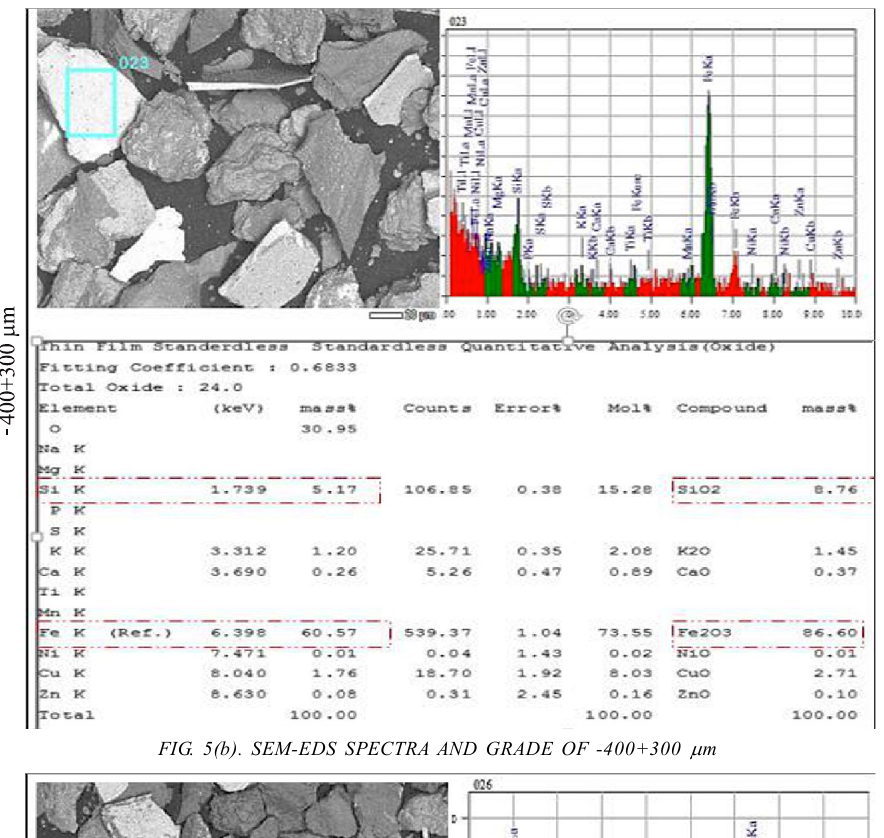
FIG. 5(b). SEM-EDS SPECTRA AND GRADE OF -400+300  m